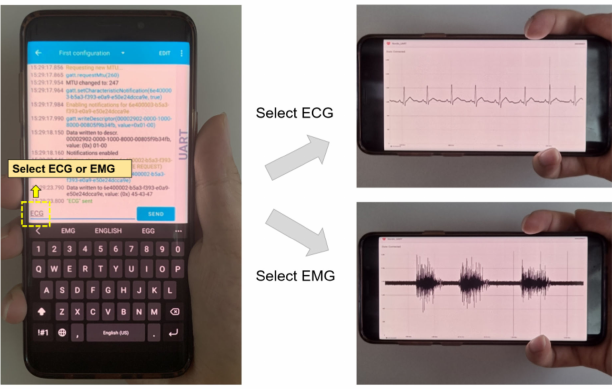
Figure 10. Mode selection and real-time signal monitoring from the host device.